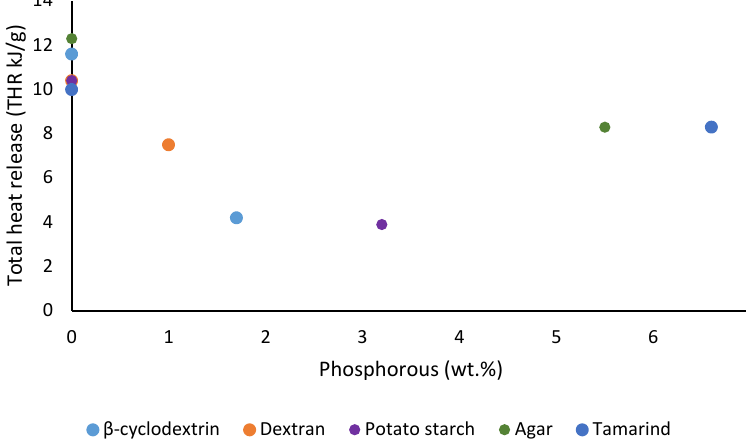
Figure 14. Plot of total heat release (THR) versus phosphorus content (wt. %) of the substrates.